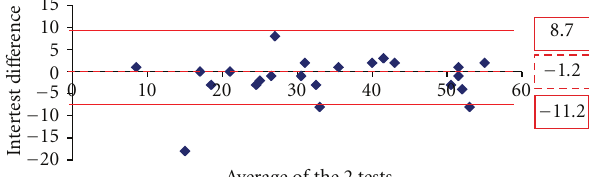
Figure 2: The Bland-Altman plot showing agreement in mean deviation between the first and second visit 10-2 SITA standard tests. The dashed line marks the average di ff erence between the two algorithms. The solid lines mark the upper and lower limits of the 95% limits of agreement.